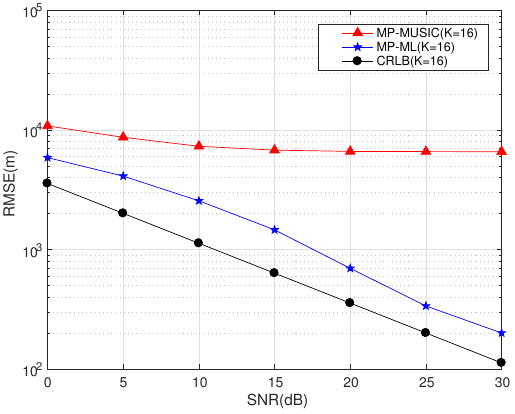
Figure 10. Performances of MP-MUSIC and MP-ML ( K = 16, J =